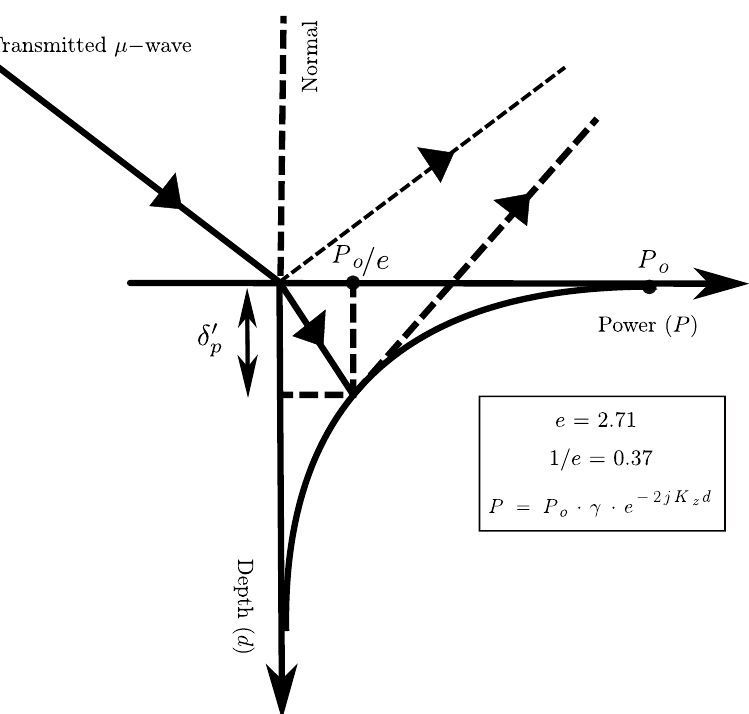
Figure 2. Schematic to show the penetration depth of microwave pulses into a soil